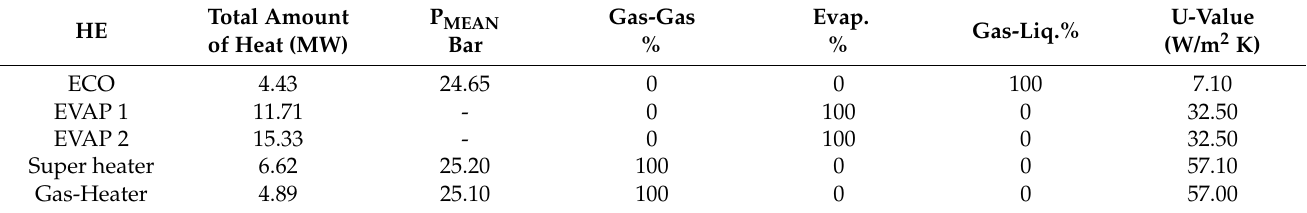
Table 3. Calculated U-Values for ATR Process heat